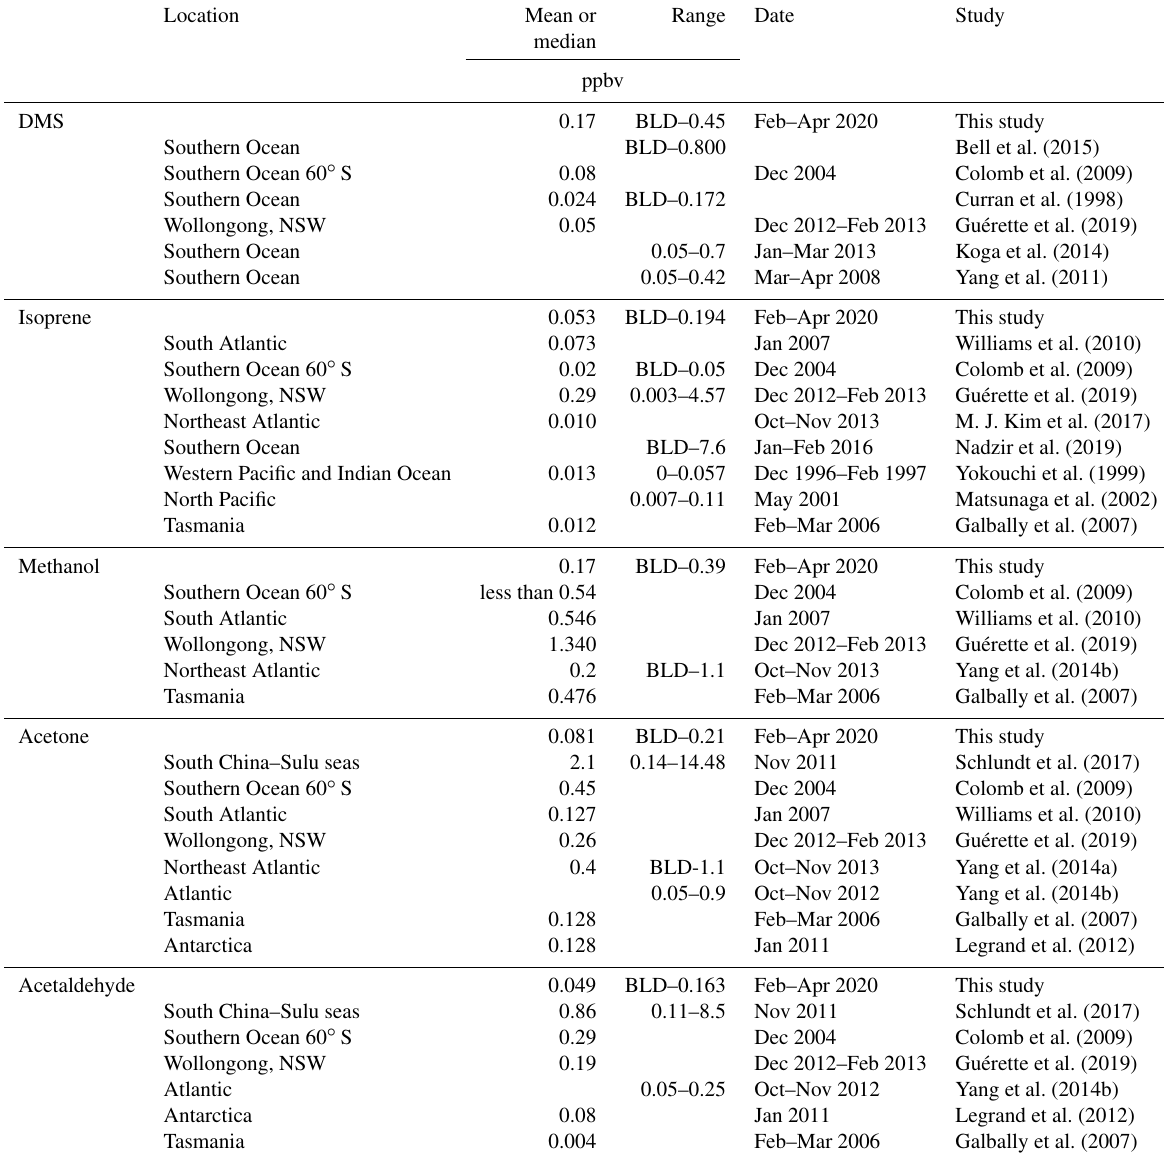
Table 5. Table summarizing previous marine ambient air measurements of DMS, isoprene, methanol, acetone, and acetaldehyde in the Southern Ocean and other regions (BLD is below limit of